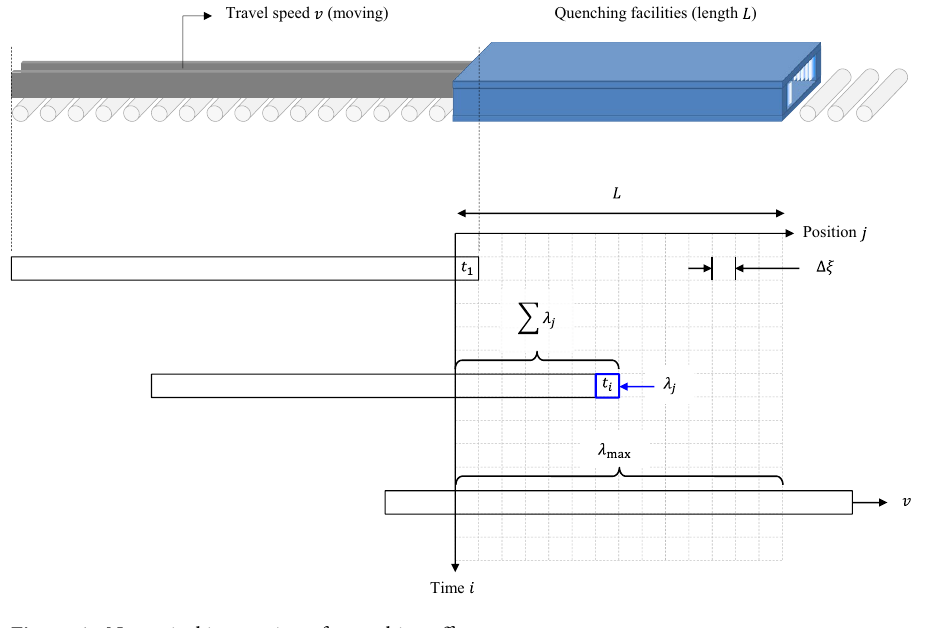
Figure 6. Numerical integration of quenching